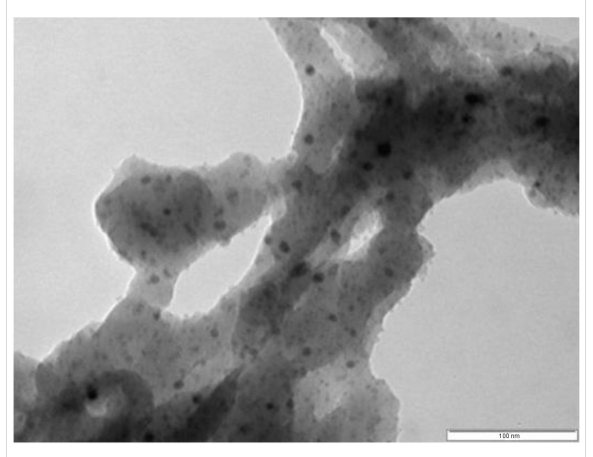
Figure 4: TEM image of Pd-monolith catalyst (scale bar: 100